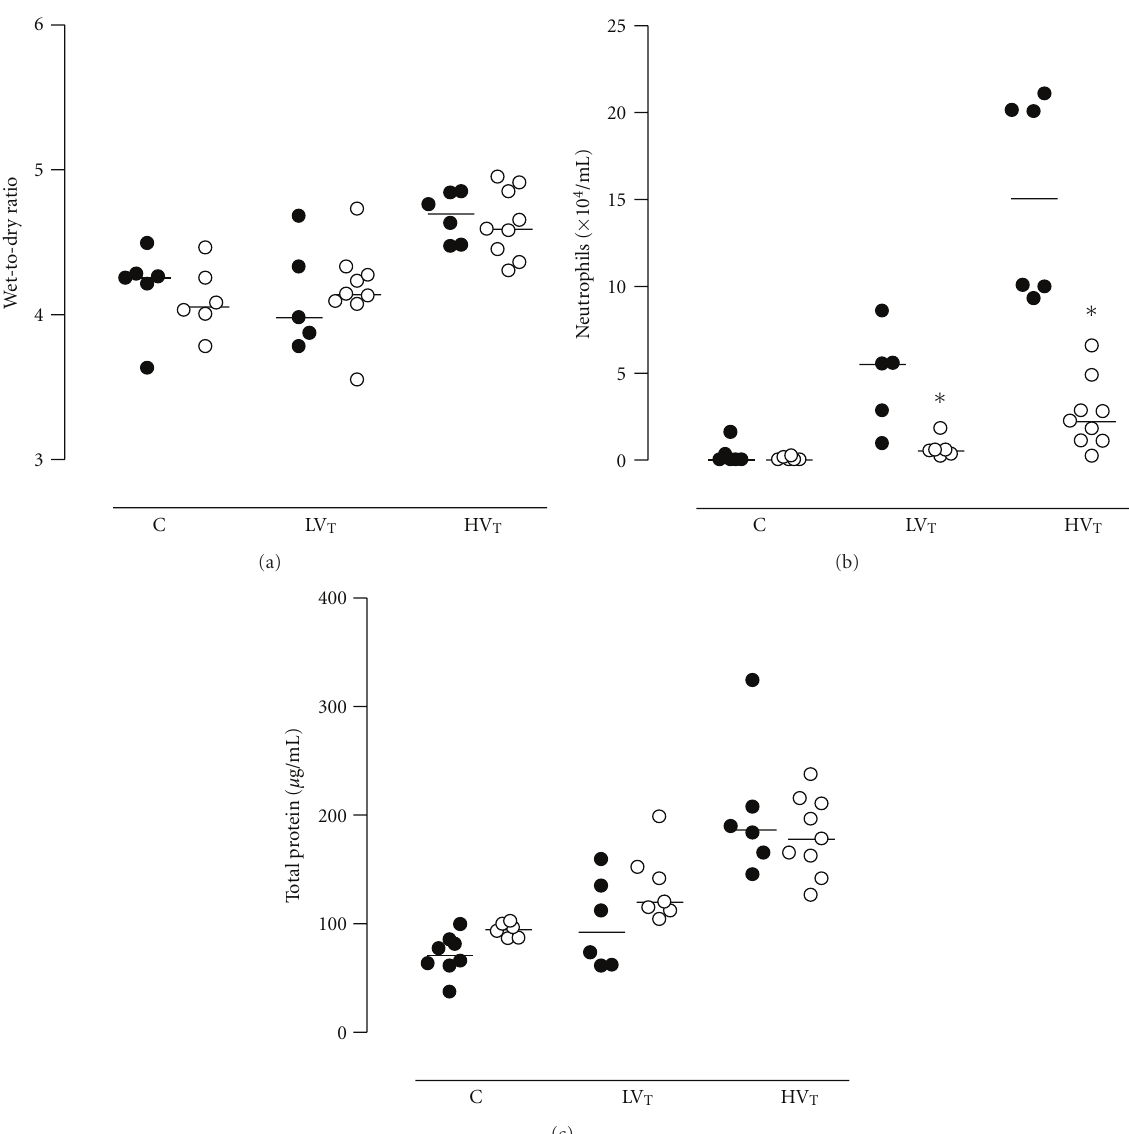
Figure 3: Wet-to-dry ratios (W/D) of the left lung, total protein level in BALF, and number of neutrophils in BALF in anesthetized nonventilated control (C) mice, mice ventilated with LV T or HV T . Mice were either PAI-1 deficient (PAI-1 − / − , open symbols) or wild type (Wt, closed symbols). Data are represented as individual data with a median. ∗ indicates statistical significant di ff erence compared to Wt.